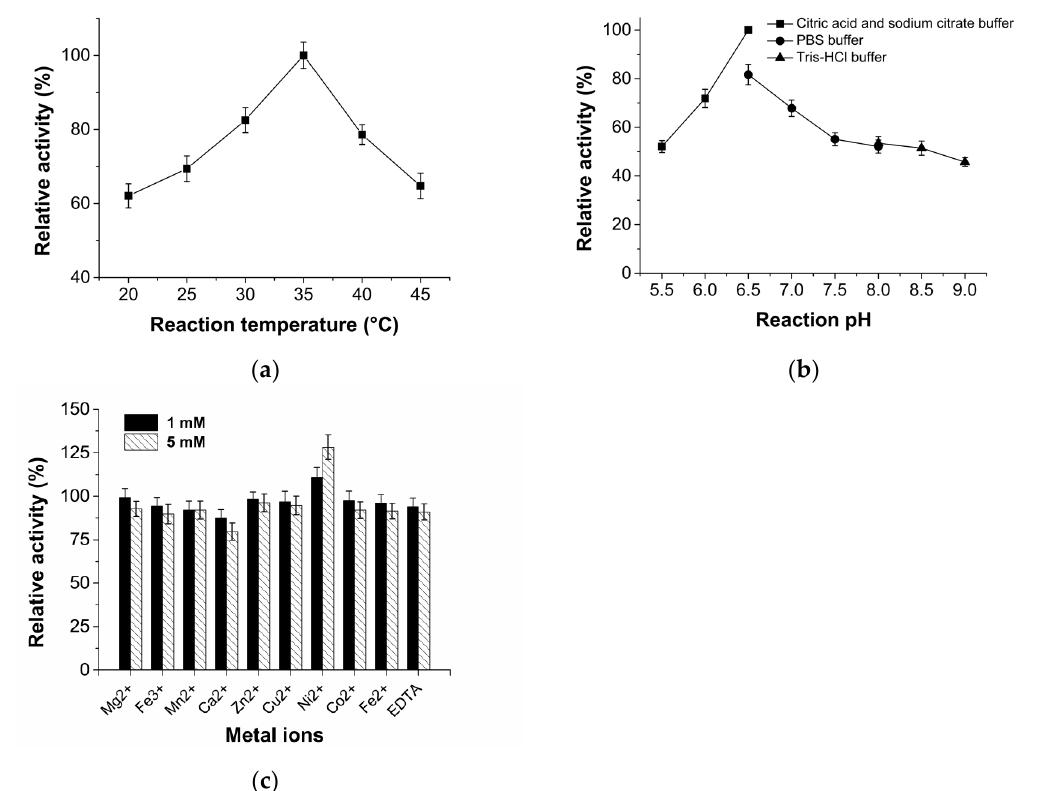
Figure 3. ( a ) Enzyme activities at different temperature levels. ( b ) Enzyme activities at different pH levels. ( c ) Enzyme activities after extra (1 or 5 mM) metal ions or EDTA addition. The specific activity of purified enzyme equal to 100% was 3.18 U mg −1 protein.